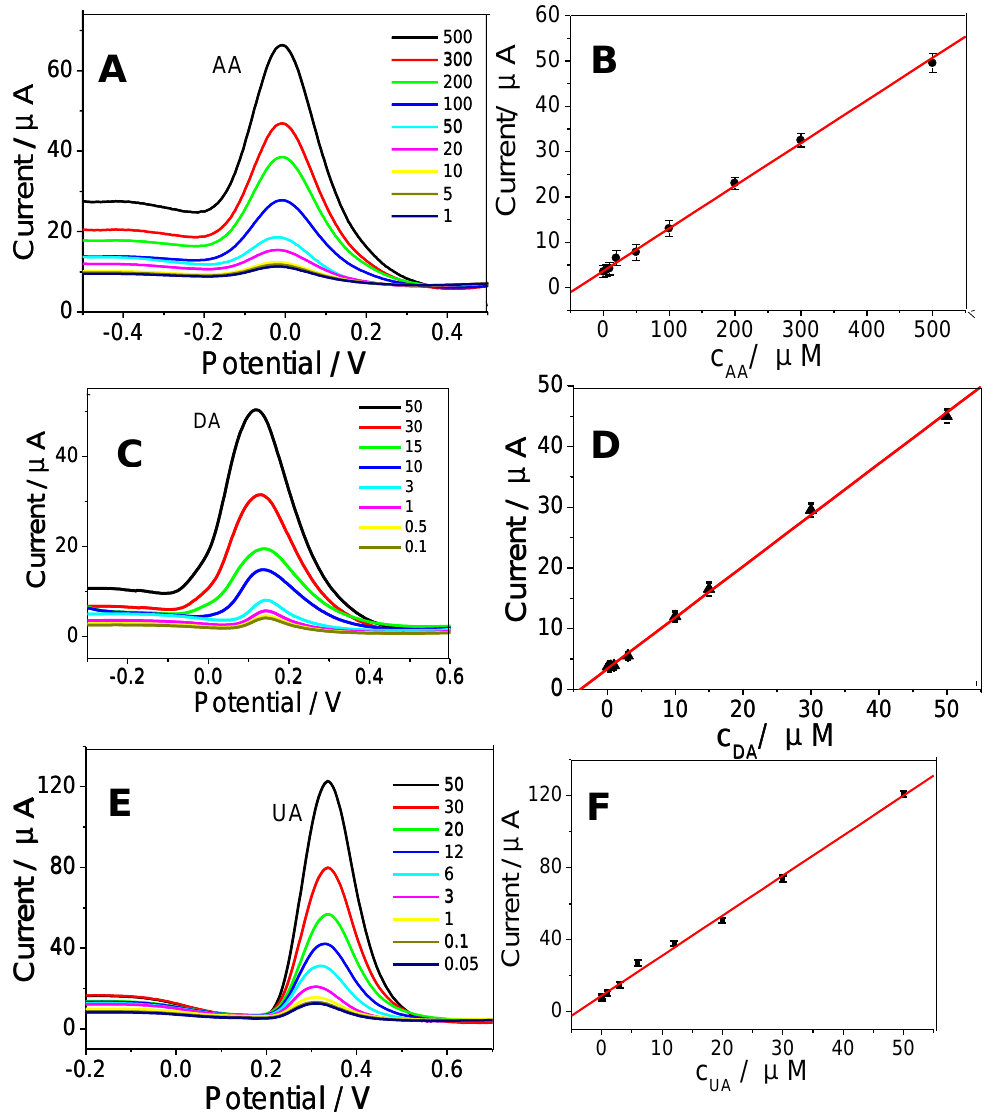
Figure 3. DPVs for 3DAu/HGO/GCE under increased concentrations of ( A ) AA, ( C ) DA, and ( E ) UA. Calibration curves for ( B ) AA, ( D ) DA, and ( F ) UA. Electrochemical parameters were the same as in Figure 2B. Table 1. Comparison of different carbon-based materials for the simultaneous determination of AA, DA, and UA.